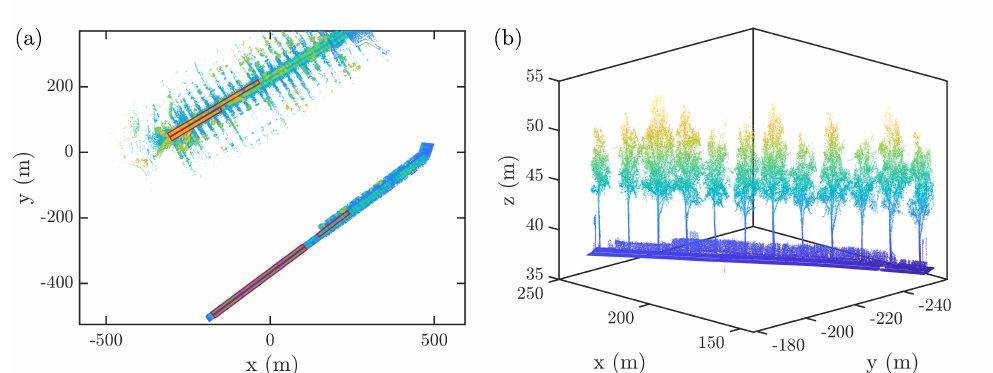
Figure 6. ( a ) Top view of the point cloud collected with the ROAMER system on Pohjolankatu and Koskelantie, together with the five rectangular regions (red lines) containing reference trees. For tree detection and stem diameter estimation, we retained the points located inside the red-colored rectangular regions that covered all 139 reference trees. ( b ) Side view of the point cloud collected with the ROAMER system within the shortest reference region on Koskelantie. In both panels, the points are colored based on the z -coordinates; the xy -coordinates of the points are centered by the mean value of the panel ( a